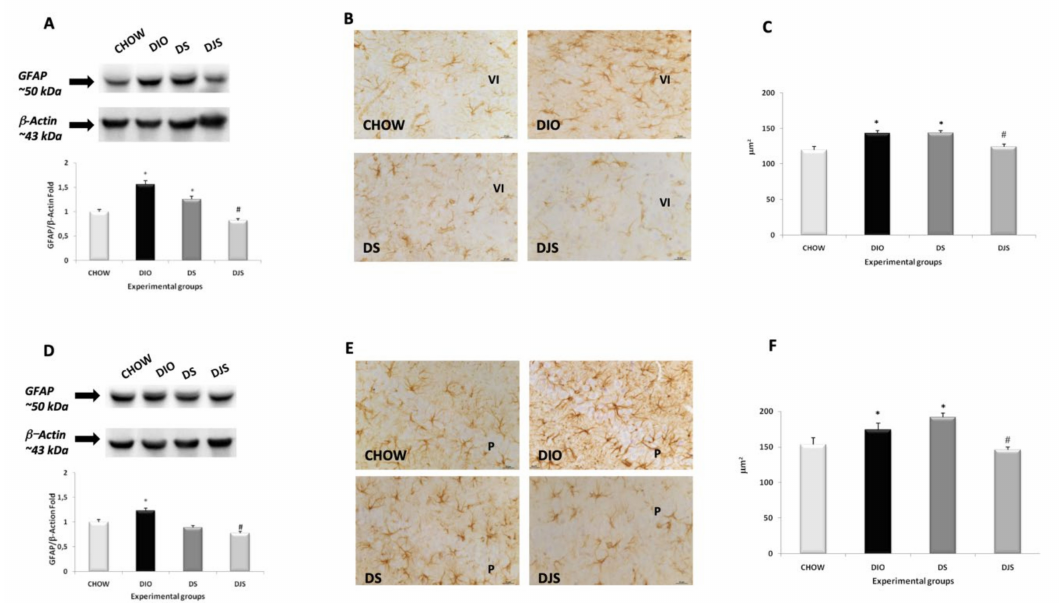
Figure 4. Expression of glial fibrillary acidic protein (GFAP). Western blot analysis for samples (representative of three di ff erent experimental sessions) of the frontal cortex ( A ) and hippocampus ( D ) probed for GFAP and β -Actin, with the corresponding densitometric analysis of the bands. Sections of the frontal cortex ( B ) and CA1 subfield of the hippocampus ( E ) processed for glial fibrillary acidic protein and the morphological analysis of the mean area of immunoreaction for the frontal cortex ( C ) and hippocampus ( F ). VI, sixth layer of the frontal cortex; P: pyramidal neurons. The values are the mean ± S.E.M.; ∗ p < 0.05 vs. CHOW rats; # p < 0.05 vs. DIO rats. Calibration bar: 25 µ